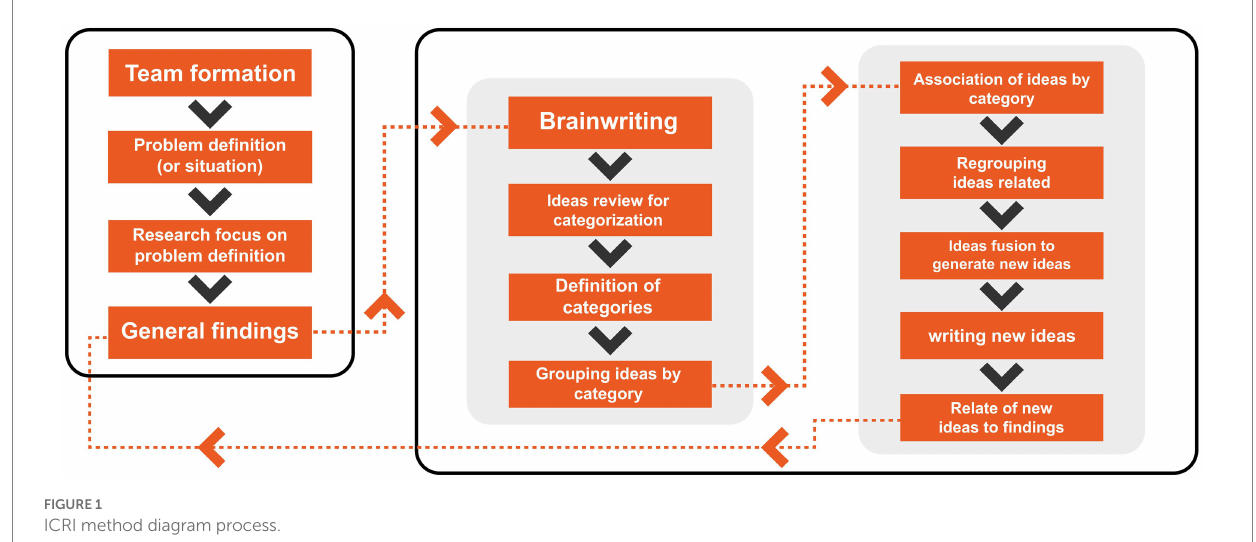
FIGURE 1 ICRI method diagram